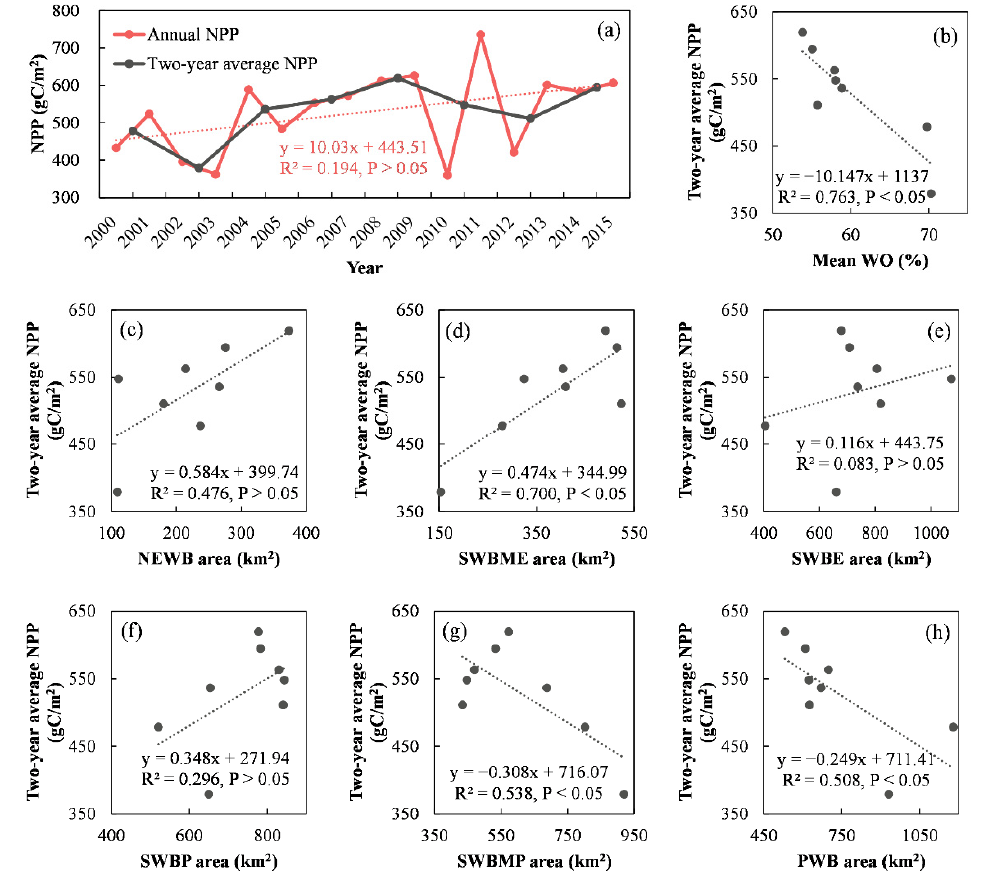
Figure 9. The relationship between water occurrence changes and NPP in Poyang Lake. ( a ) indicates the time series of NPP, ( b ) indicates the relationship between mean WO and NPP, and ( c – h ) indicate the relationship between water body area of different types and NPP. The WO was calculated on a two-year scale; therefore, the study calculated the two-year average NPP series for linear regression analysis.